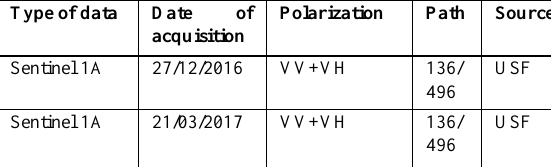
Table 4: Sentinel 1A SAR data for water pixels extraction Type of data